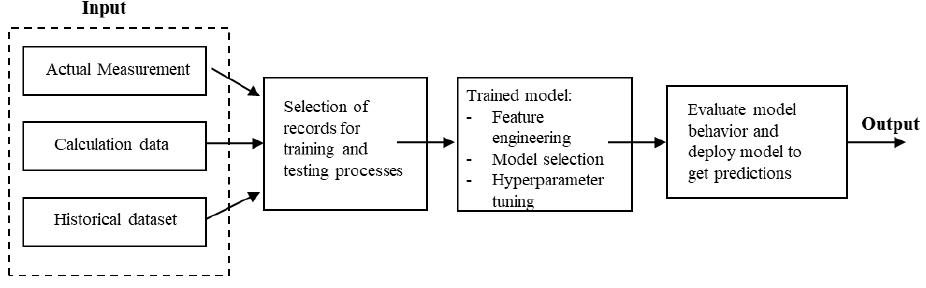
Figure 4. The basic structure of machine learning method.